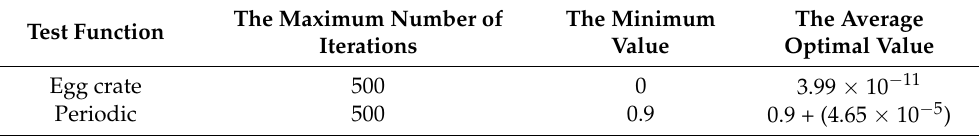
Table 1. Test results of the two benchmark functions.